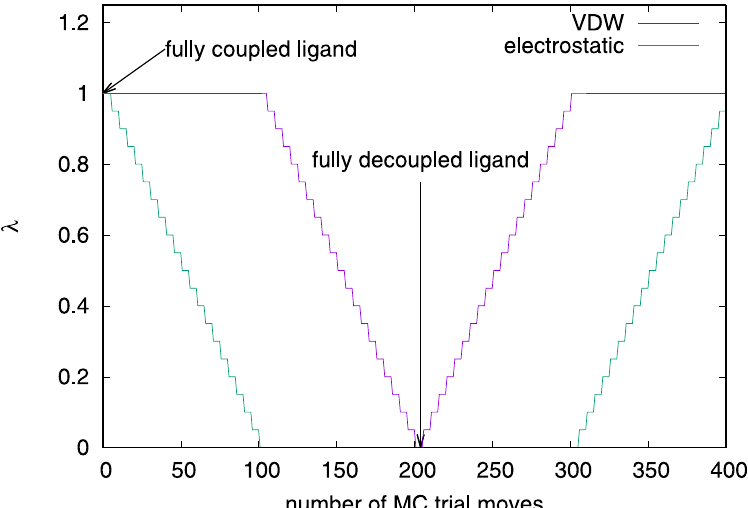
Fig 2. Scaling of λ VDW and λ elec over each NCMC trial-move cycle. The cycle comprises four phases, each containing 100 individual MC trial moves. First, the charges on the ligand are removed by gradually reducing λ elec to 0. Second, the ligand is fully uncoupled from the protein by reducing λ VDW to 0. Third, the van der Waals interactions of the ligand with the protein are restored by increasing λ VDW back to 1. Finally, the charges on the ligand are restored by increasing λ elec back to